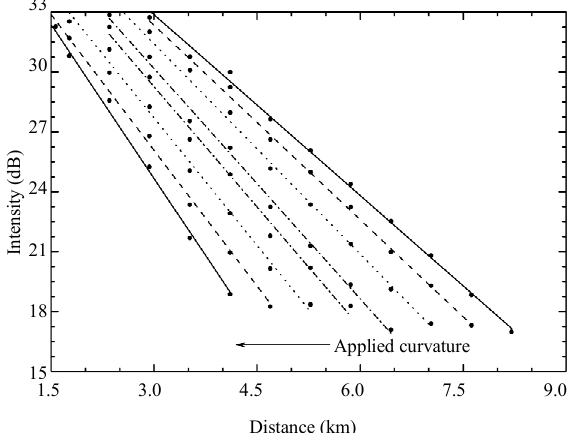
Fig. 2 Intensity as a function of the length along the fiber, representing the OTDR profile for the absence of applied curvature. Inset is the linear behavior of the OTDR.